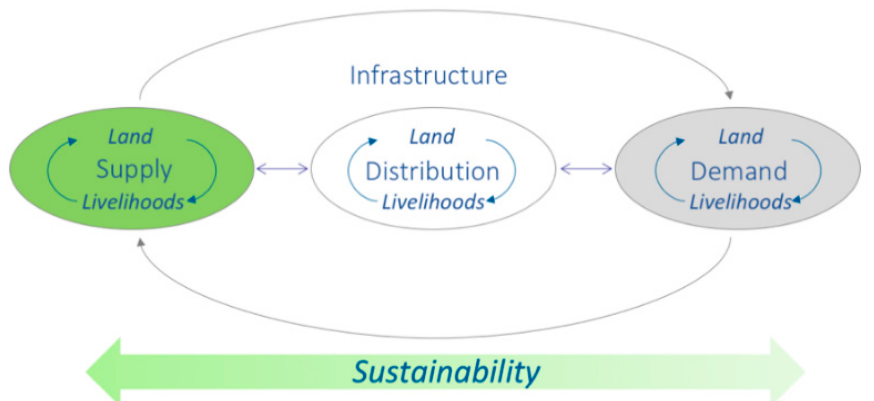
Figure 1. Conceptual model depicting relationships between the supply and demand of ecosystem services, as well as the role of infrastructure in the distribution of these services. Rural and urban regions are the suppliers and consumers, respectively, of ecosystem services. Exurban regions carry the infrastructure to deliver these services. In each region, the strength of these interactions leads to changes in land use, and ultimately people’s livelihoods. The sustainable management of ES in tropical mountains requires a full consideration of these interactions.